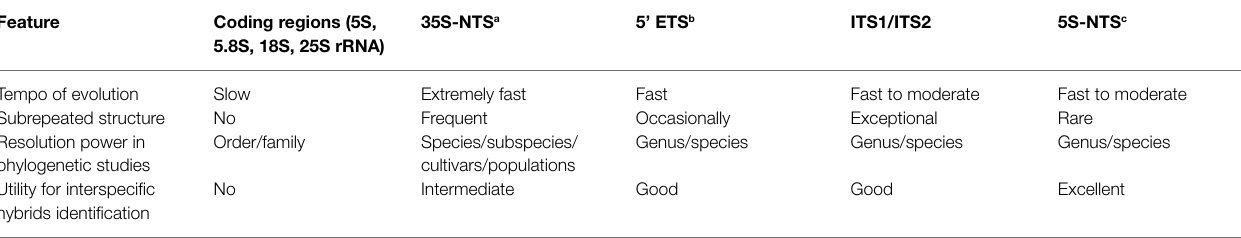
TABLE 1 | Characteristics of individual subregions of plant rDNA units and their relevance for phylogenetic analysis.